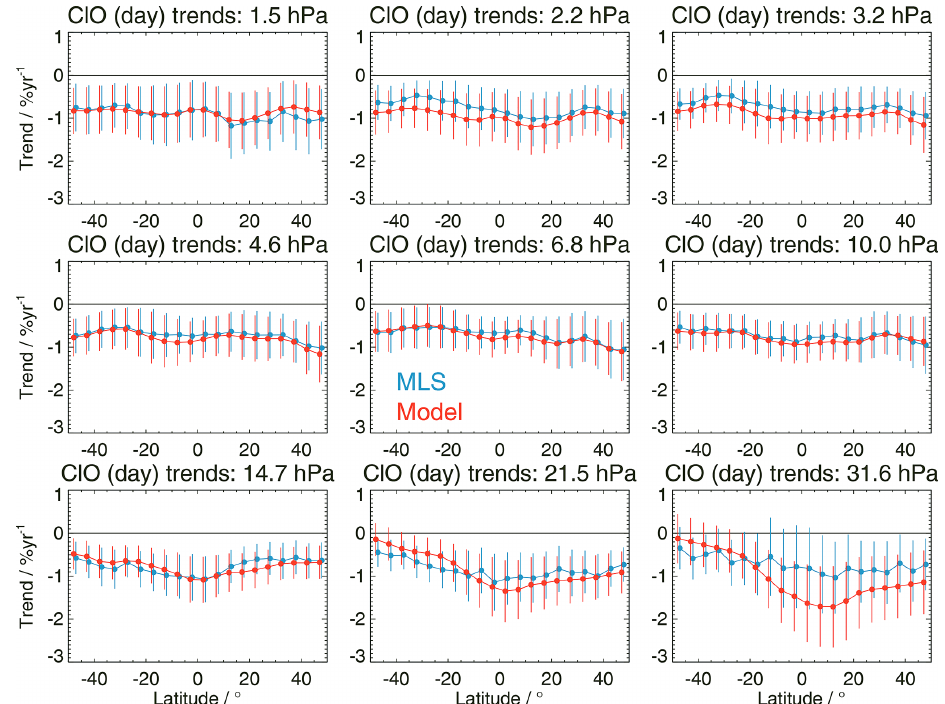
Figure 3. Linear trends in upper stratospheric ClO (2005 through 2020) at different pressure levels versus latitude, as obtained from multiple regression analyses applied to monthly zonal mean daytime series from MLS (blue) and the model (red). Error bars depict the uncertainties (2 σ ) for these trend results, based on block bootstrap analyses of the monthly residual series from the fits to the MLS and model